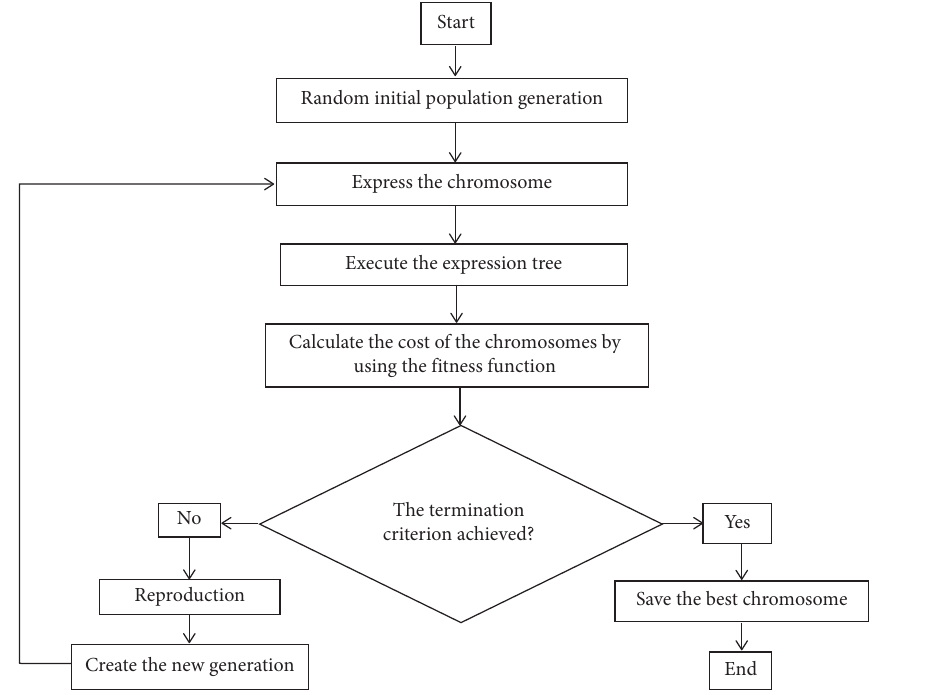
Figure 1: Simple flowchart of the GEP method [22]. Table 1: The sources of the